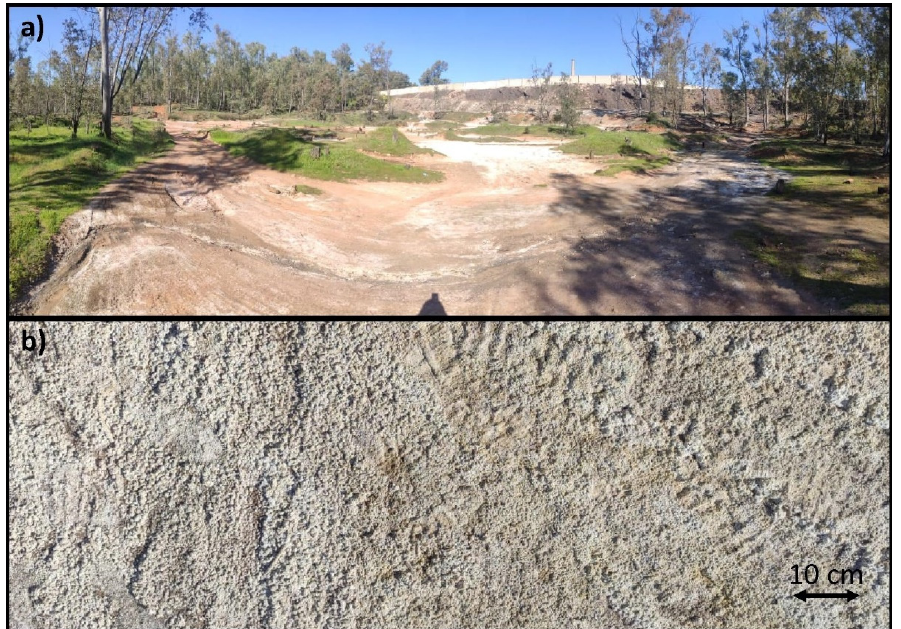
Figure 1. Contaminated soil in the Linares mining district: ( a ) general image of the area and ( b ) detailed image of the soil.